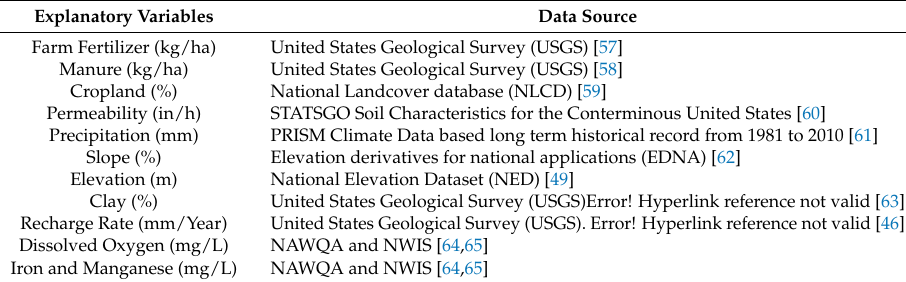
Table 4. Explanatory variables in Geodetector